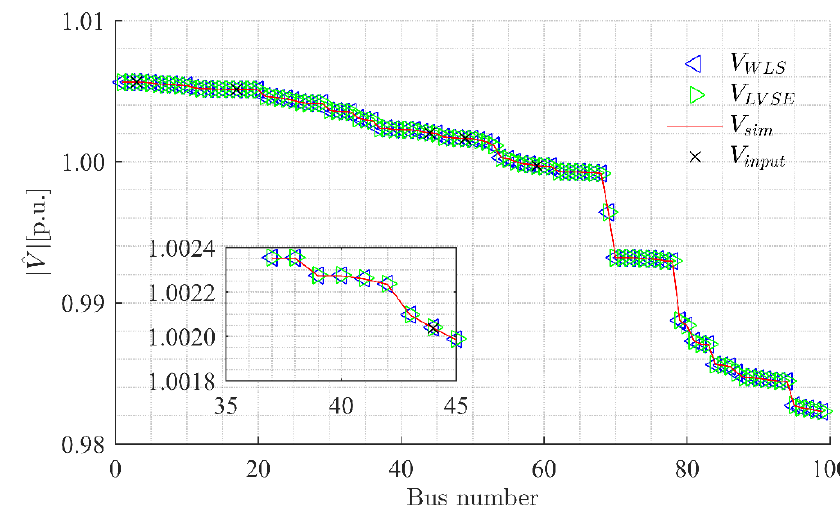
Figure 3. Network voltage profile—case 1.